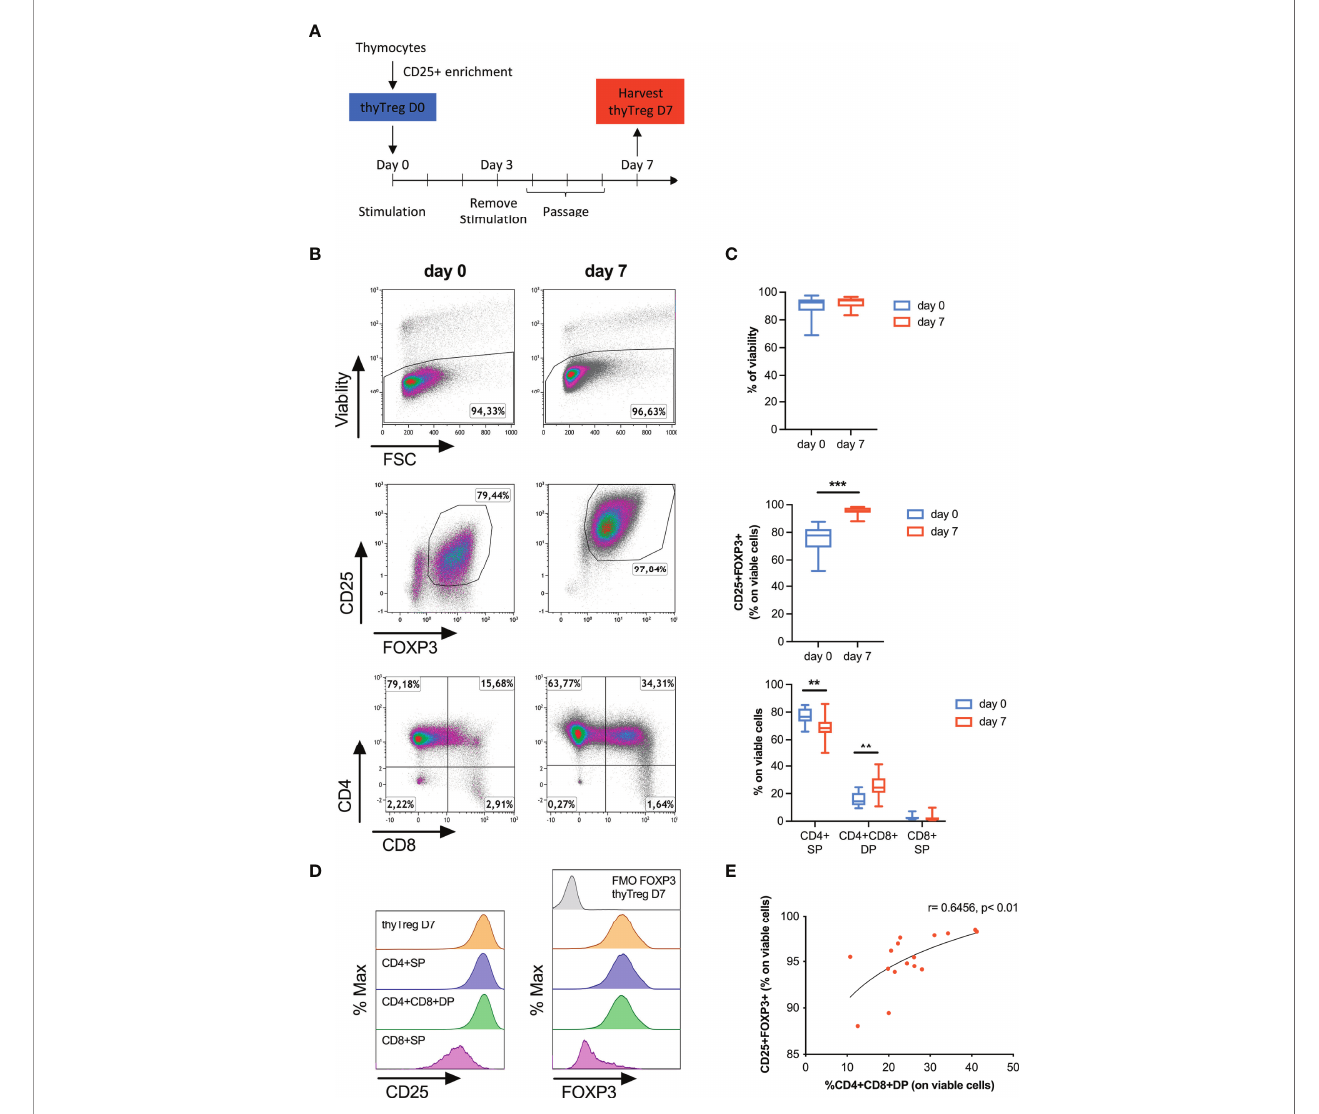
FIGURE 1 | Characteristics of manufactured thyTreg. (A) Isolation and culture protocol for thyTreg obtention. (B) Representative fl ow cytometry dot plots showing the viability, purity and CD4/CD8 phenotype of thyTreg right after isolation (day 0) or after culture (day 7). (C) Summary of the cell viability, purity and CD4/CD8 phenotype of n=16 thyTreg at days 0 (blue) and 7 (orange). The graph shows min-median-max. **,P < 0.01 and ***,P < 0.001 (paired Wilcoxon test). (D) Representative fl ow cytometry histograms showing CD25 (left) and FOXP3 (right) expression in thyTreg CD4/CD8 subsets. To determine the background signal, the fl uorescence minus one (FMO) of FOXP3 is shown. (E) Correlation between the frequency of CD4 + CD8 + DP and the purity of thyTreg product (Pearson correlation